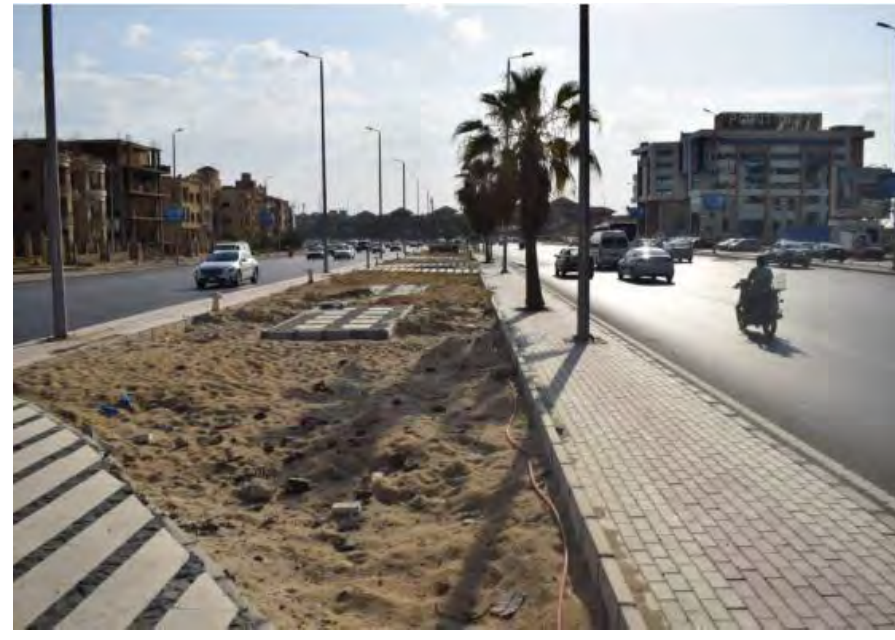
Fig. 28 Poor landscape. (Source: the authors)